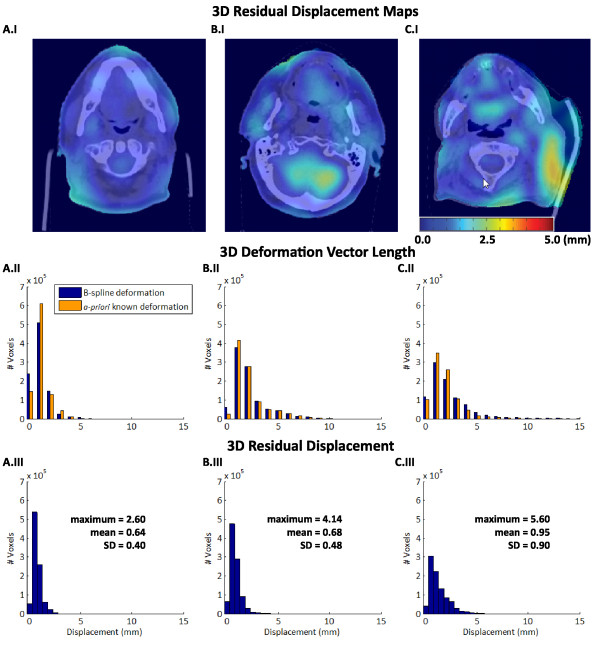
Registration results of three head-and-neck CT cases (patient A, B, C) with a realistic known imposed displacement derived from a rescan CT of the same patient. The images in row I show the 3D residual displacement maps between the simulated moving image and the target image, plotted on an axial CT slice of the planning CT. The histograms (row II) indicate the 3D deformation vector length of the known imposed displacements and the resulting registration. The histograms (row III) indicate the 3D residual displacements between known imposed displacements and the resulting registration at BKS = 15 mm.